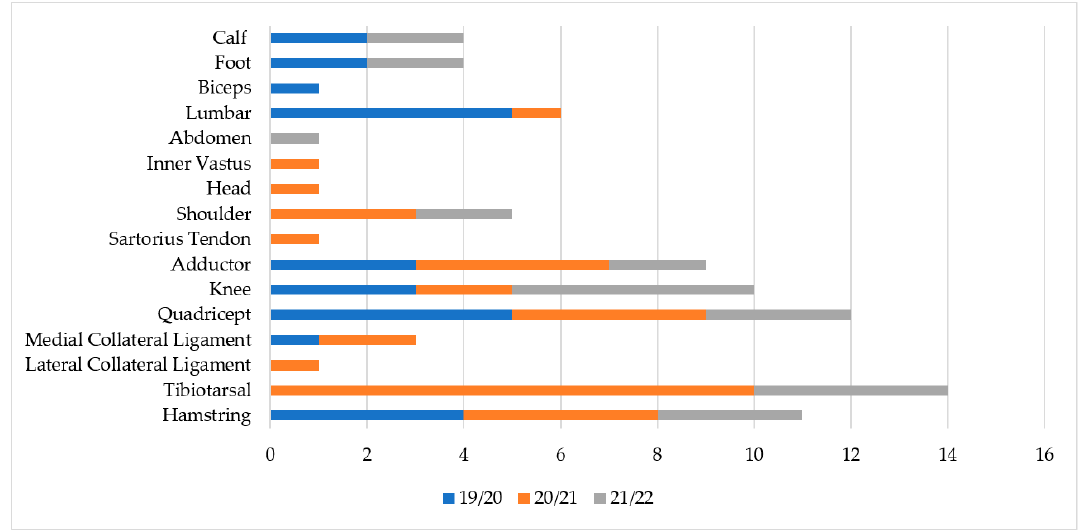
Figure 3. Injury frequency by specific location (n).